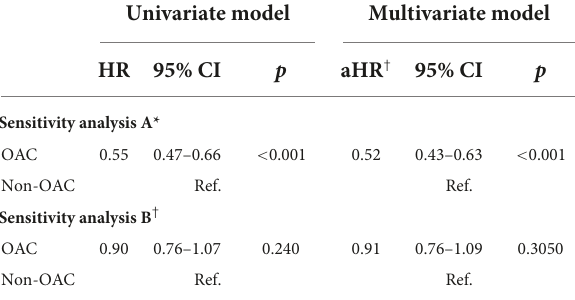
TABLE 3 Sensitivity analyses in the risk of ischemic stroke in IPTW